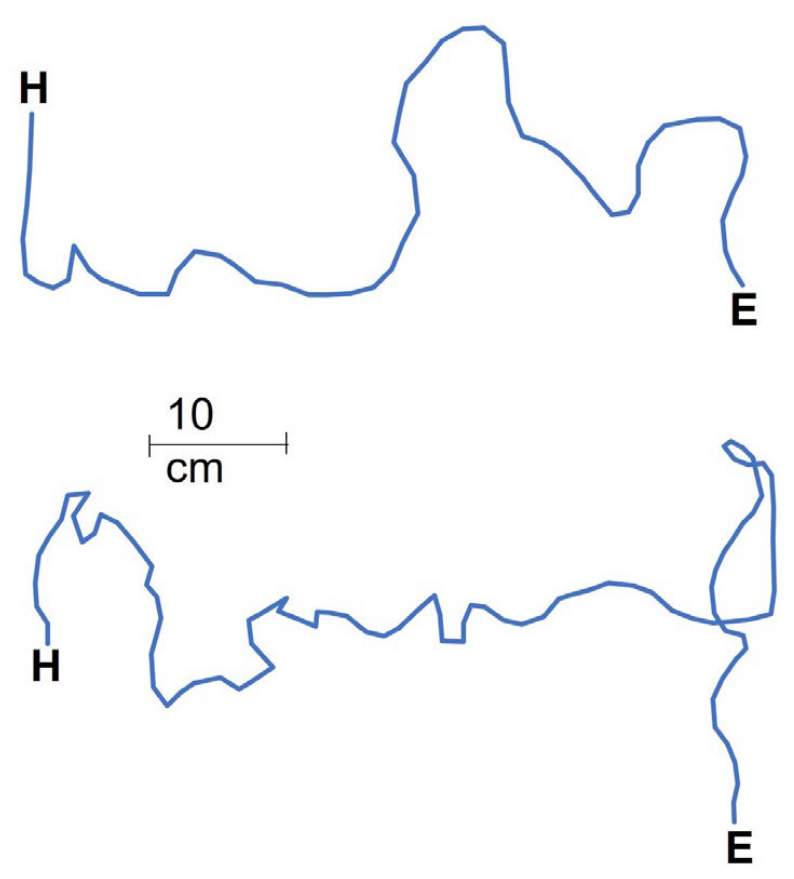
Figure 4. Two examples (above: control, no pits; below: six pits) of movement tracks from the arena entry (E) to the food reward (H) during the third run.